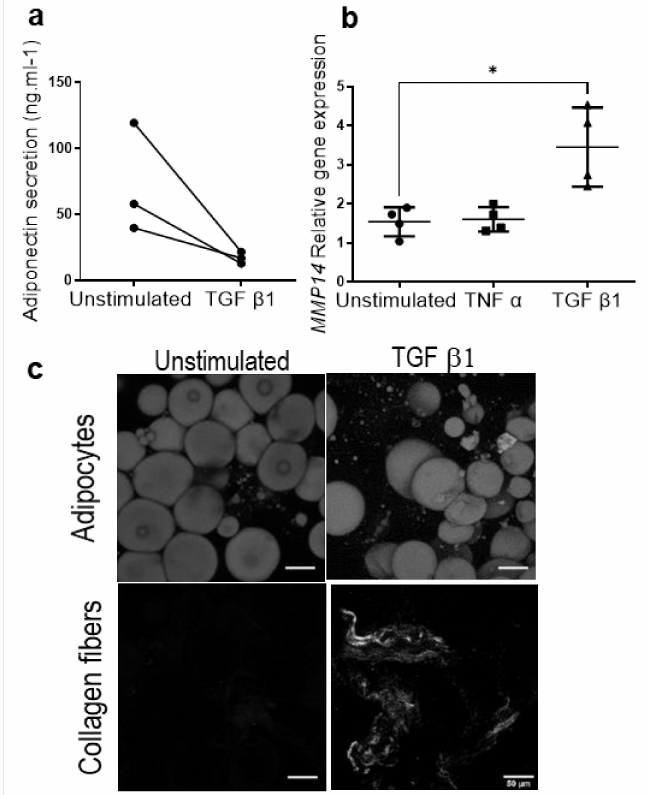
Figure 5. Generation of the ExAdEx fibrotic-like model. ( a ) Levels of secreted adiponectin. Ten mg of the ExAdEx model was treated with 5 ng/mL TGF β 1 for 7 days, and the levels of secretion during the last 24 h of the treatment were determined by ELISA; n = 3 donors. ( b ) The expression of the MMP14 gene determined by qPCR; n = 4 donors. * p ≤ 0.05. ( c ) The visualization of fibrotic collagen fibers by SHG imaging. Scale bar: 50